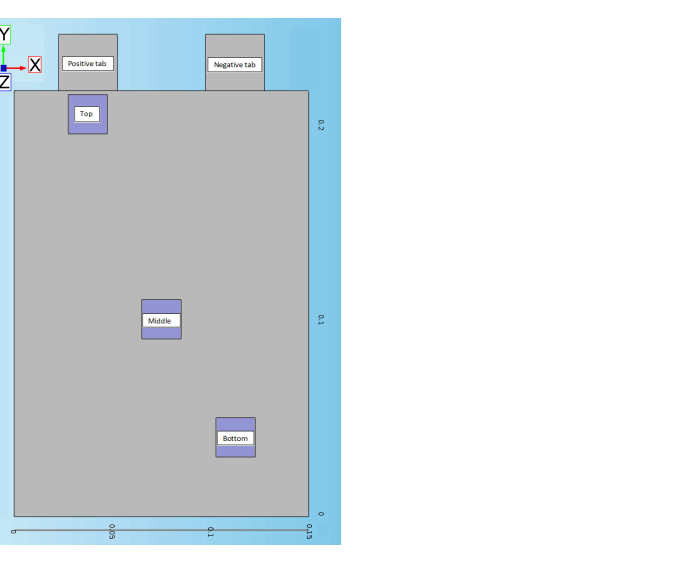
Figure 6. Battery cell schematic and regions for disposition of temperature